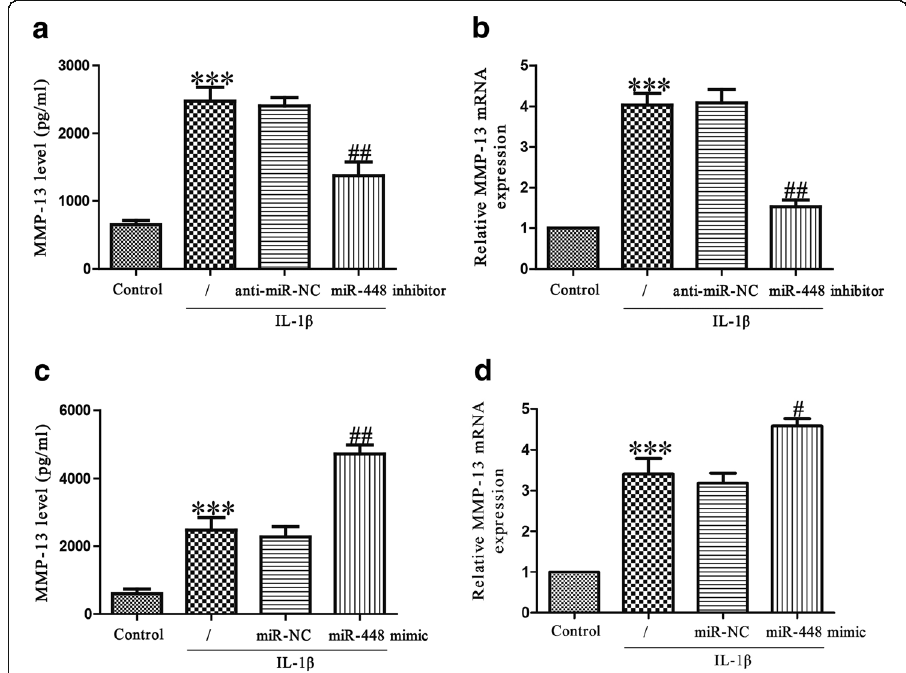
Fig. 3 Effect of miR-448 on IL-1 β -induced MMP-13 in chondrocytes. Chondrocytes were treated with IL-1 β (5 ng/ml) for 24 h after transfection with miR-448 mimic or inhibitor. a , c The expression level of secreted MMP-13 protein was determined using ELISA. b , d The mRNA level of MMP-13 was determined using quantitative real-time PCR. The data shown are means ± SEM, n =4. *** p <0.001 vs. control; # p <0.05, ## p <0.01 vs. vehicle + IL-1